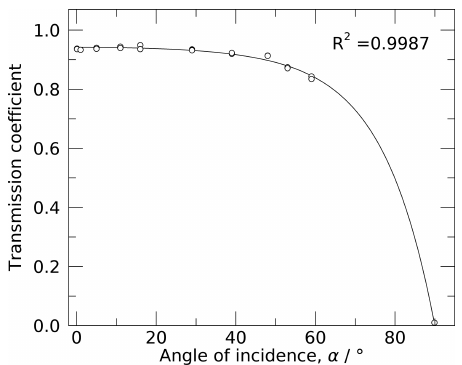
Figure 6. Transmission through the quartz glass of the measurement chamber as function of the incidence angle α (see Fig. 8a) as open circles. The curve shows a two-parameter fit to the data based on Fresnel’s laws (Eq. 3).